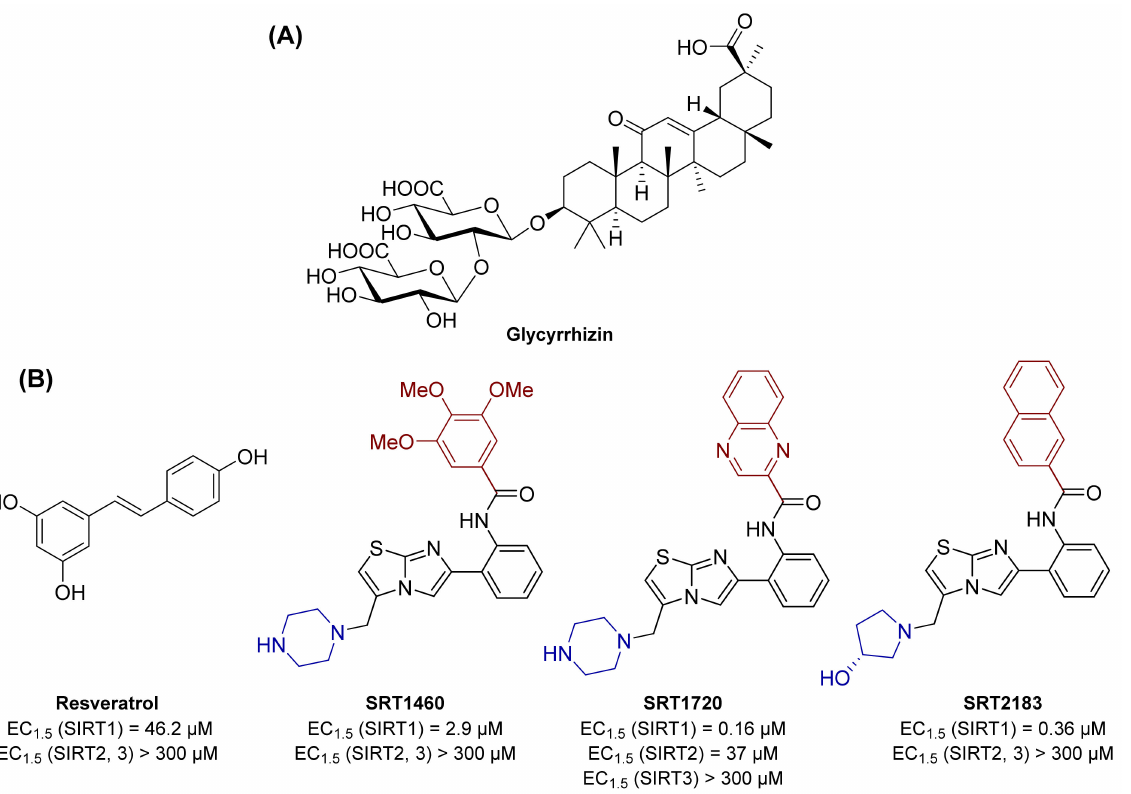
Figure 1. ( A ) Structure of the naturally occurring compound glycyrrhizin, possessing an indirect effect on SIRT1 activity. ( B ) Structures and enzymatic activities of direct SIRT1 activators resveratrol, SRT1460, SRT1720, and